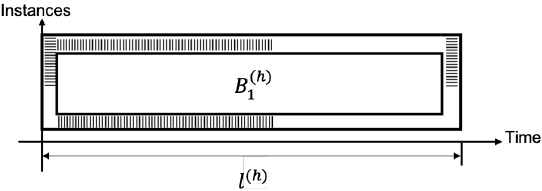
( h ) , requiring l ( h ) clock cycles (latency). 1